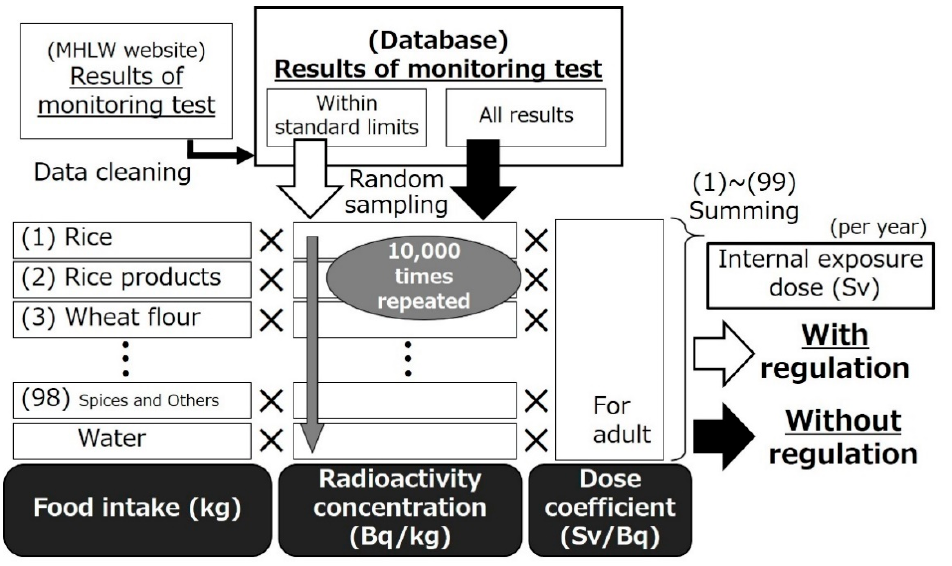
Figure 2. Schema of data acquisition and dose calculation. Random sampling was repeated from the monitoring results within the standard limits or for all results. The radiation exposure dose of virtual 10,000 persons depends on the presence or absence of food regulations was calculated as the product of the food intake, sampled radioactivity concentration in each food and dose coefficient.